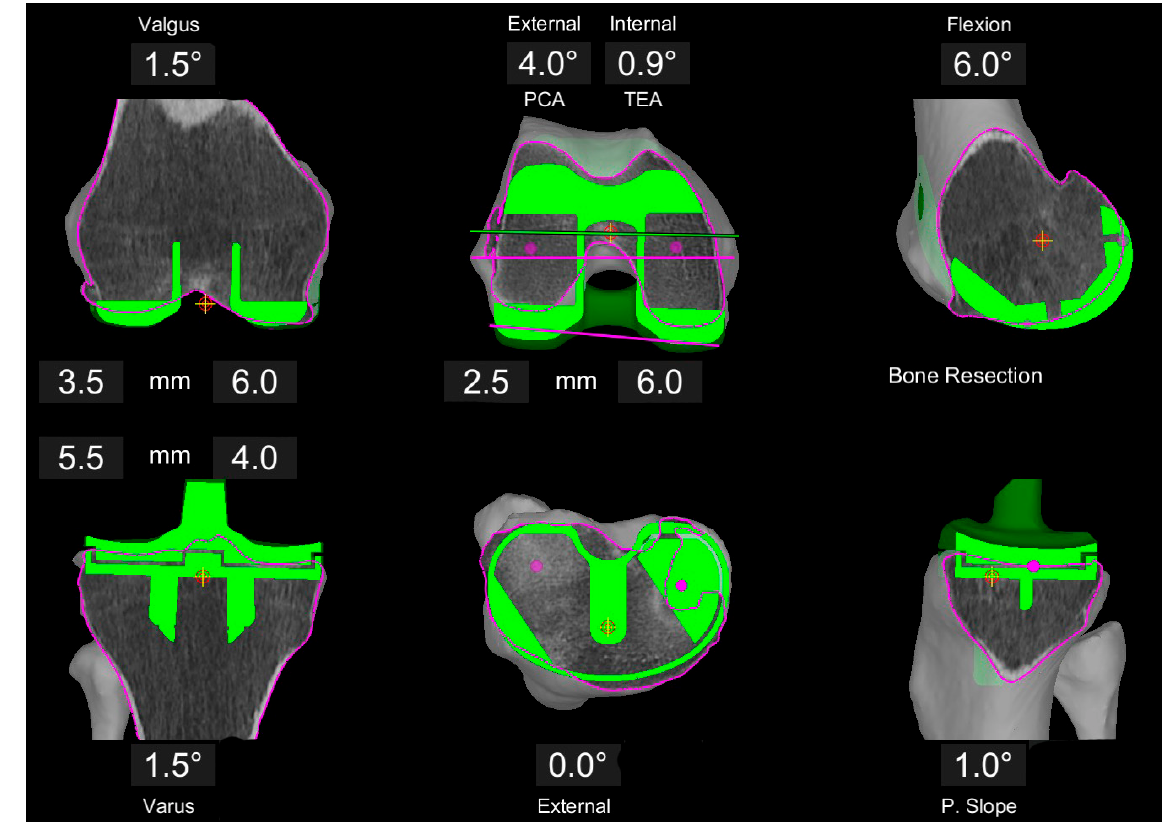
Figure 2. Example of a varus knee planned with restricted KA. The distal femoral resection is symmetric at 6 mm, whereas the posterior resection is adjusted to co-align the trochlea groove close to the native trochlea axis. This results in a 3.1° external rotation with respect to the PCA. Tibia follows the same principle as for KA (Figure 1).